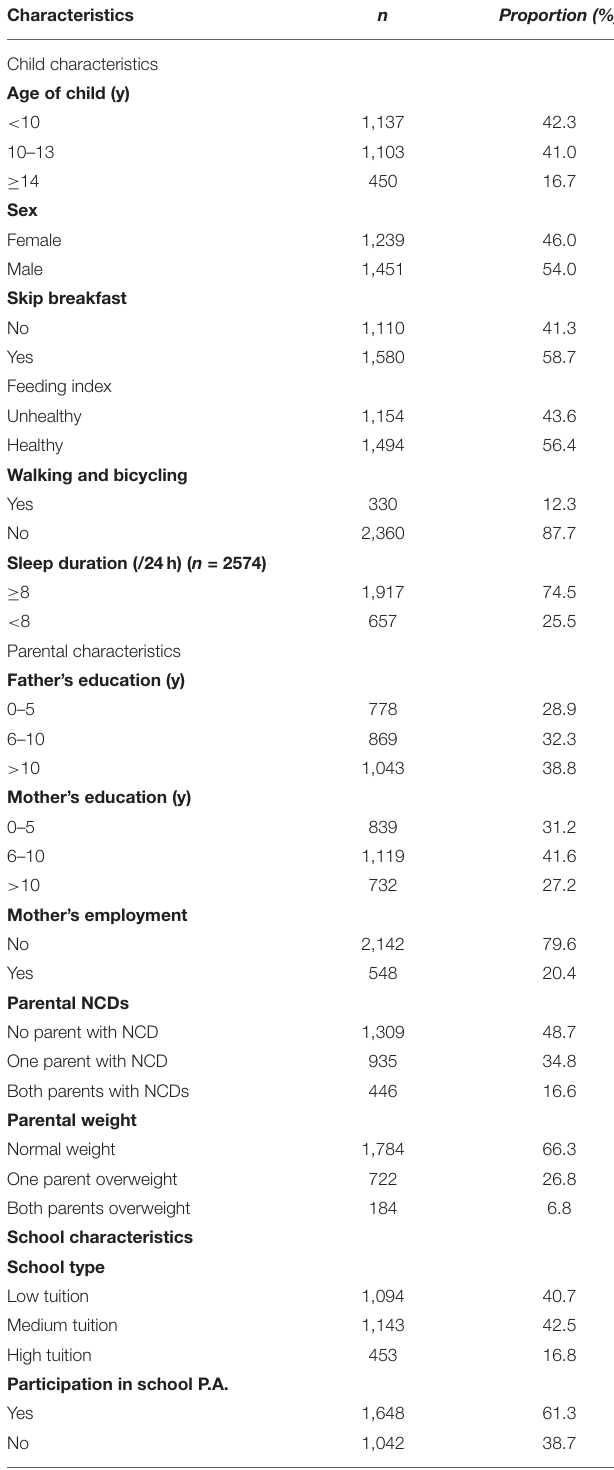
TABLE 2 | Characteristics of the study participants ( n = 2,690). Characteristics n Proportion